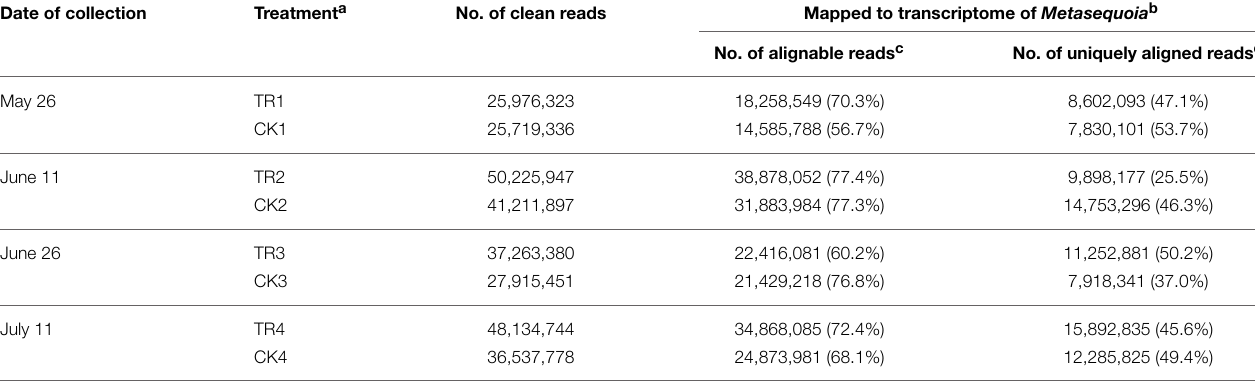
TABLE 1 | Summary of RNA-seq and mapping results of Metasequoia